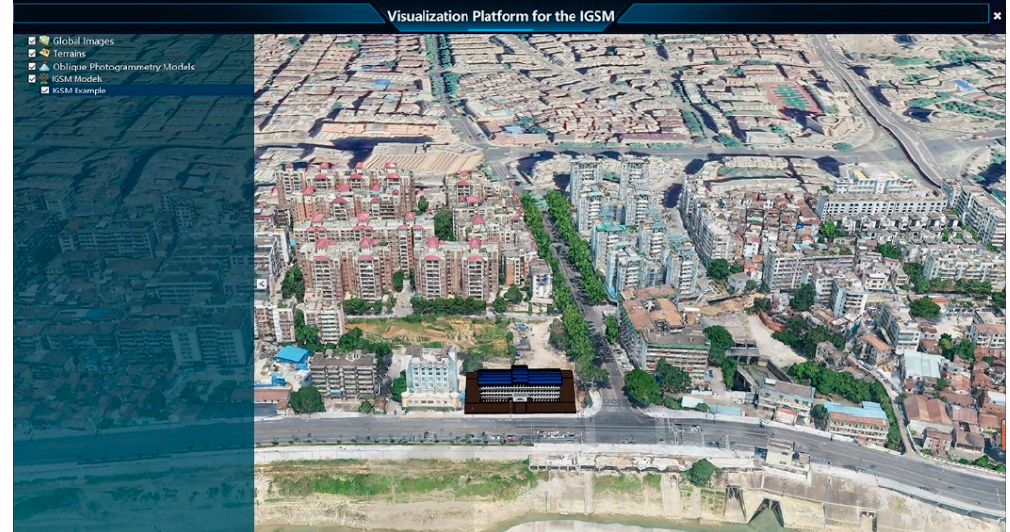
Figure 14. Overall display effect of the IGSM in the virtual globe (sample data from Table 2. Office Building).